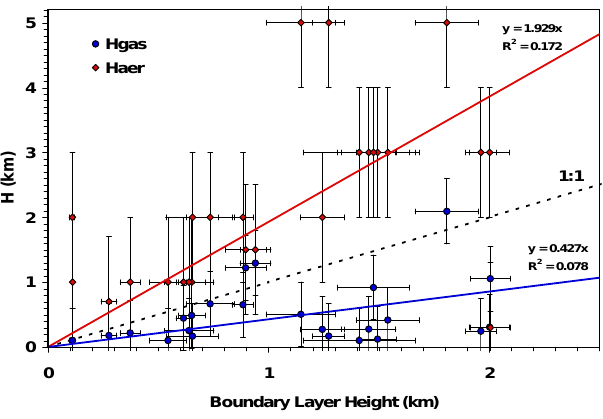
Fig. 9. Correlation between MAX-DOAS-RTM retrieved layer heights and boundary layer heights determined by LIDAR backscat- ter